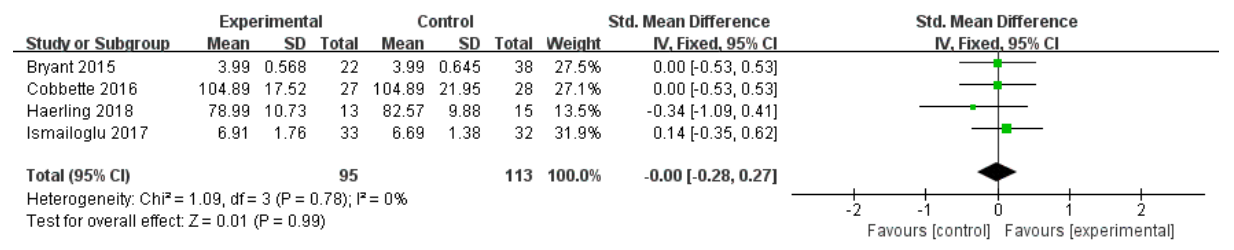
Figure 7. Forest plot of virtual reality on